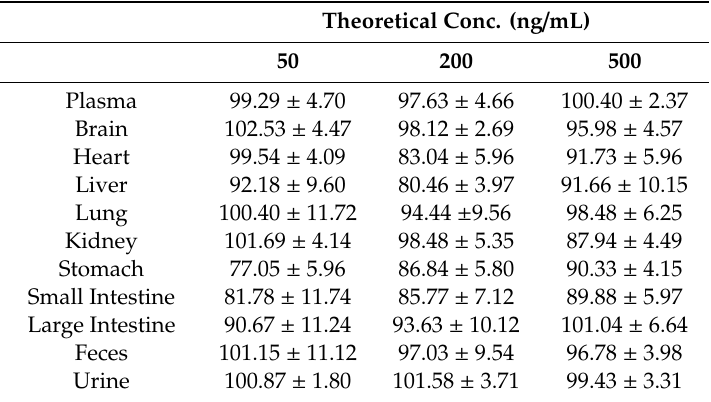
Table 2. Extract recoveries (%) of Erinacine S in rat plasma and tissues.